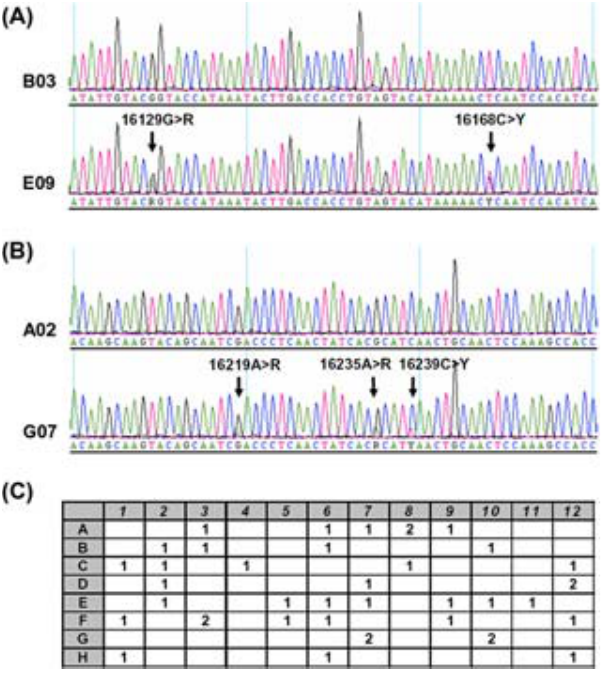
Figure 1. Recognition of mtDNA sequence anomalies in single cell analysis. Sections of representative sequence electropherograms showing external DNA contamination in a single cell from samples A- 2 (A) and donor 7 (B), together with an uncontaminated cell from the respective sample. Sites with heteroplasmic mutations (R for A and G; Y for C and T) were scored relative to the Cambridge Reference Sequence [3]. (C) Occurrence of contamination events in the wells of the 96-well plate in analyzing 7094 single cells. The numbers in the wells indicated the number of contamination instances observed in the respective well. Wells with no contamination were left